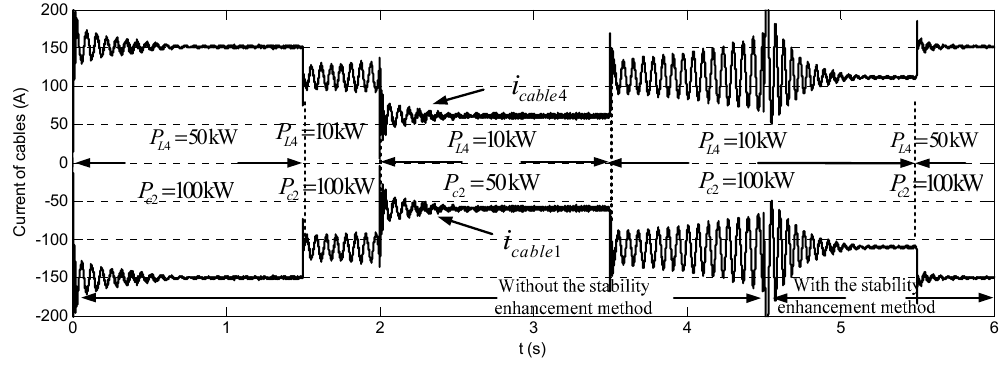
Figure 18. The currents of cable 1